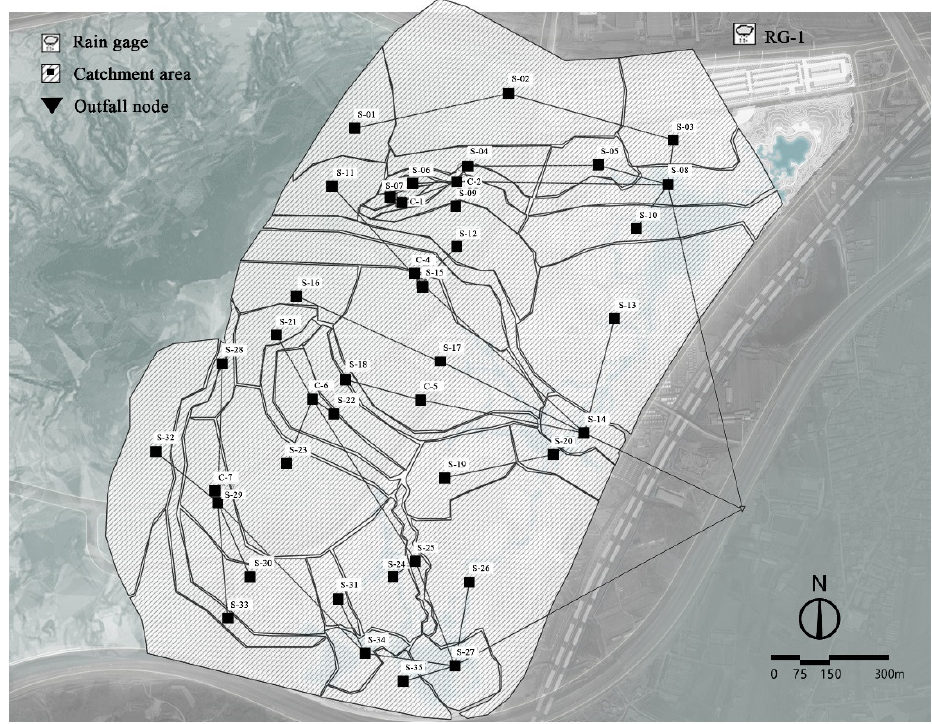
Figure 4. Subdivision map of site catchment area before construction.